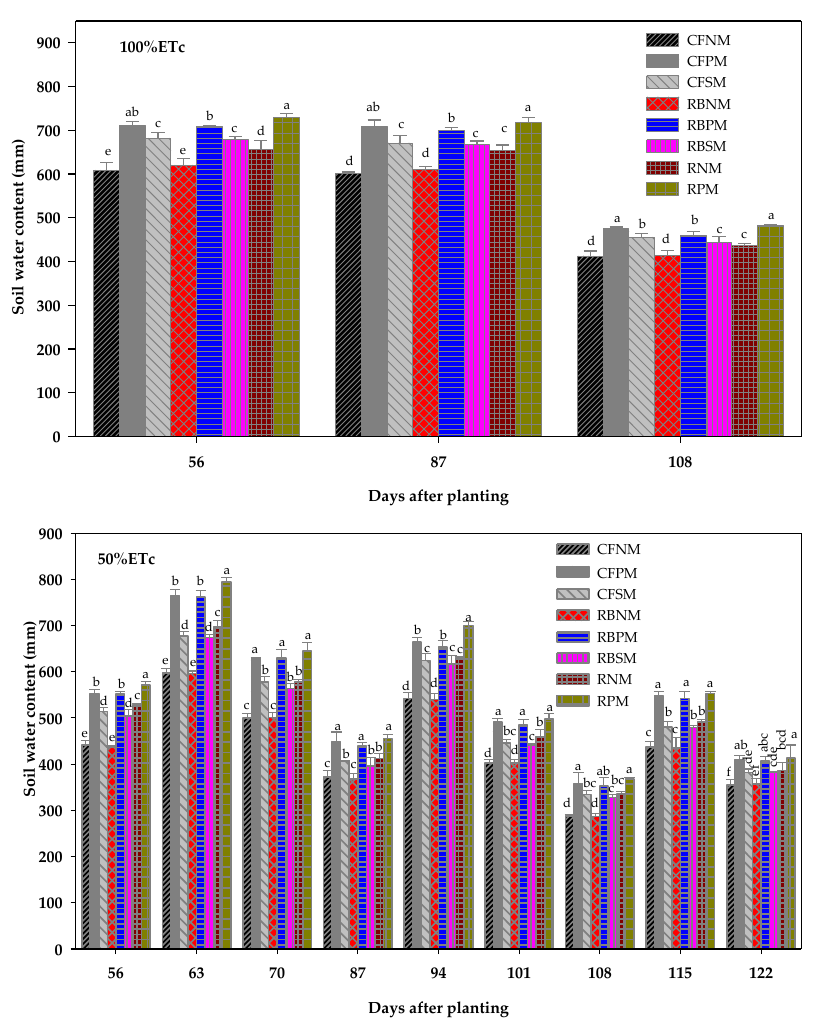
Figure 5. Effects of different planting patterns under full (1.00 ET) and limited (0.50 ET) irrigation rate on total soil water storage in the 0 – 60 cm soil layer over two growing seasons at different durations (in days) after sowing. Conventional flat planting (CF) without mulching (CFNM); CF with plastic film mulch (CFPM); CF with wheat straw mulch (CFSM); raised-bed planting (RB) without mulch (RBNM); RB with plastic film mulch (RBPM); RB with wheat straw mulch (RBSM); ridge – furrow planting (RF) without mulch (RFNM); and RF with plastic film mulch on both ridges and furrows (RFPM). Bars with different letters are significantly different from each another on the basis of Duncan’s multiple range test at P ≤ 0.05 .